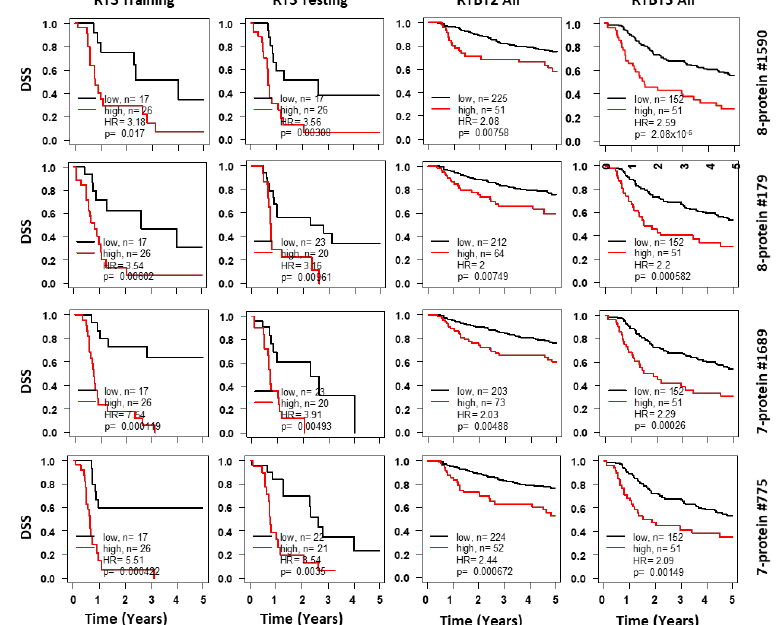
Figure 3. Kaplan-Meir curves for Ridge models developed with the RT3 dataset. Shown for each representative model are survival curves for the training subset (column 1), testing subset (column 2), validation in the RTBT2 (column 3) and RTBT3 datasets (column 4). Patients in each training subset were divided into high (40%) versus low (60%) for survival comparison and the cutoff threshold was applied to the testing and the independent RTBT2 and RTBT3 datasets. Results for selected protein models are presented here.